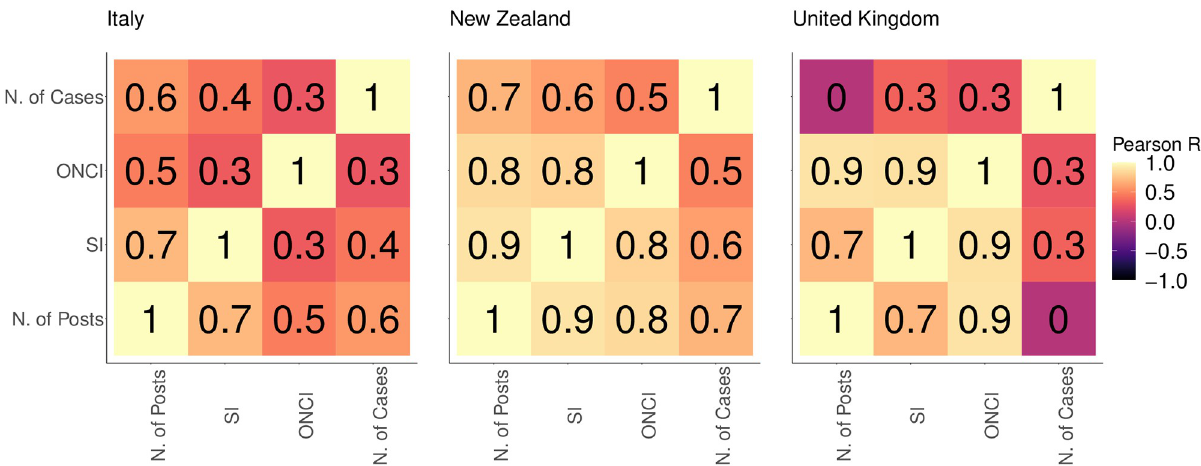
Fig 4. Pearson’s correlation coefficient among ONCI (Online News Coverage Index), SI (Stringency Index), Number of COVID-19 Confirmed Cases and Posts computed on a weekly base for Italy (left), New Zealand (middle) and United Kingdom (right).